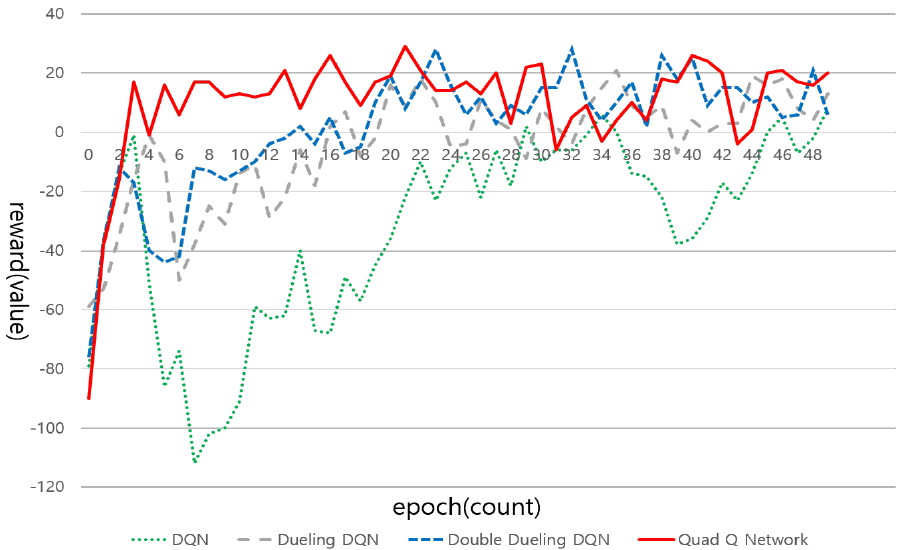
Figure 10. Comparative analysis of the proposed Q Network reward for the value of Total Resource on Google.